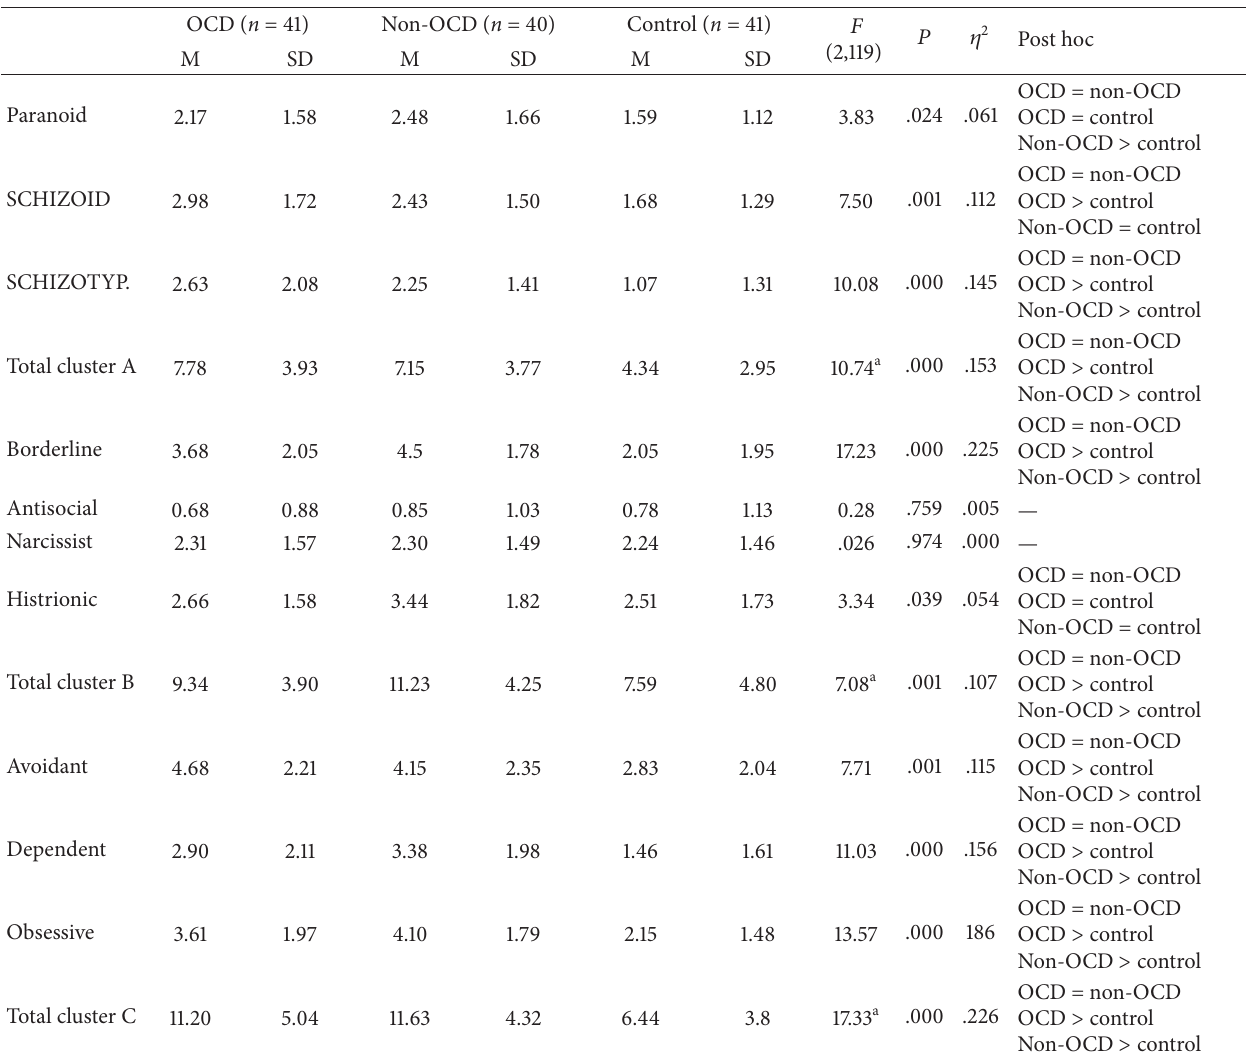
Table 2: Results of ANOVA analysis for comparisons among OCD, non-OCD, and control group in IPDE